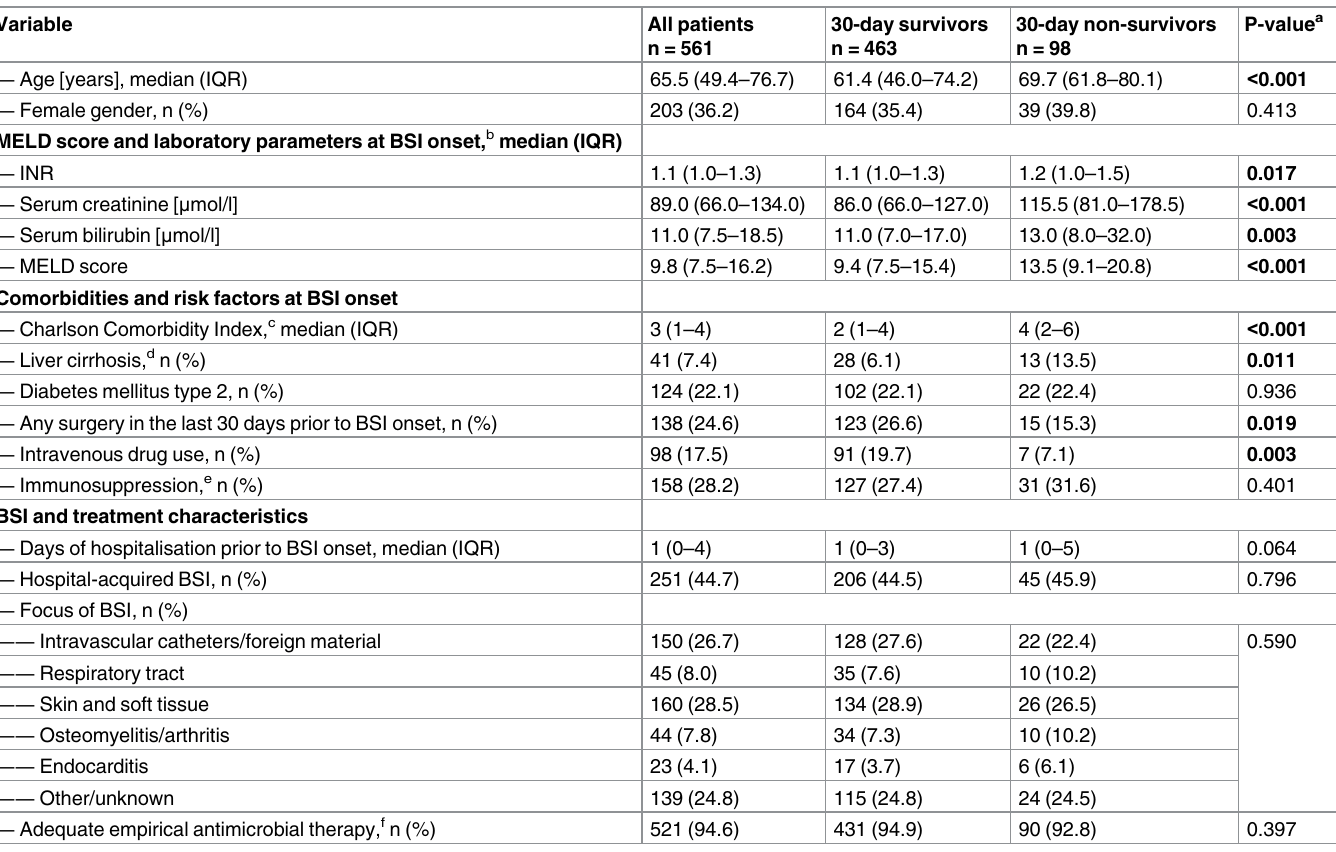
Table 1. Demographic, Laboratory and Infection Characteristics of Patients with a Staphylococcus aureus Bloodstream Infection (n =